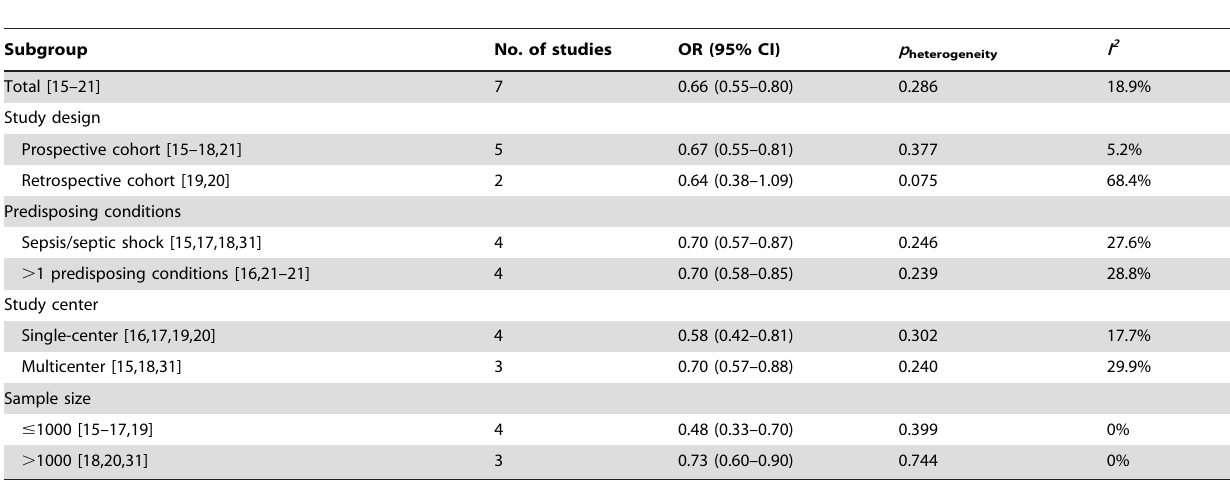
Table 2. Subgroup analyses for